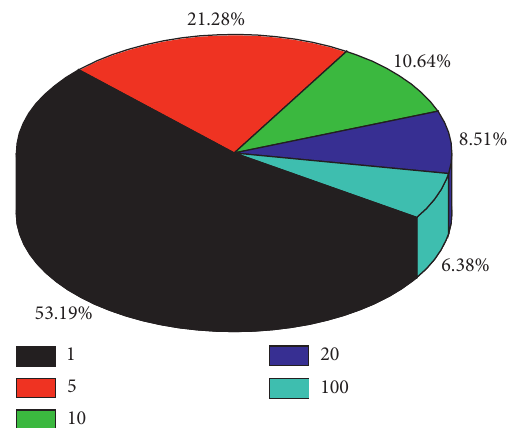
Figure 4: Number of base classifiers and generalization